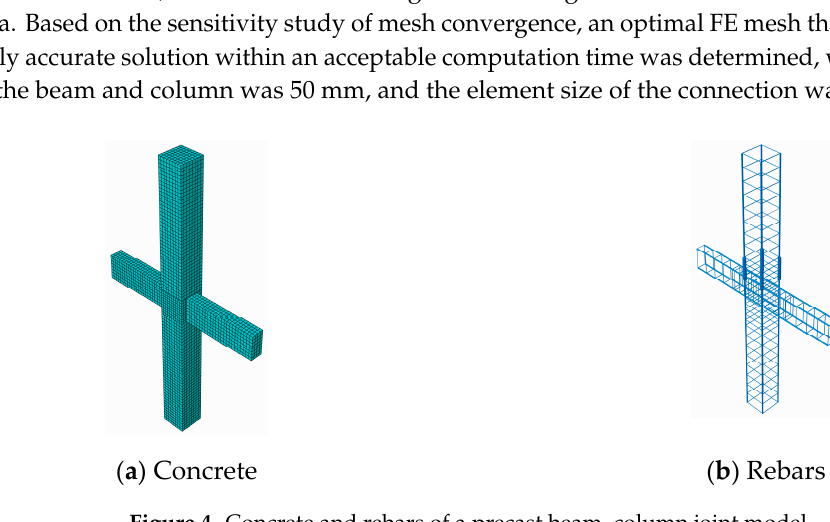
Figure 4. Concrete and rebars of a precast beam–column joint model.